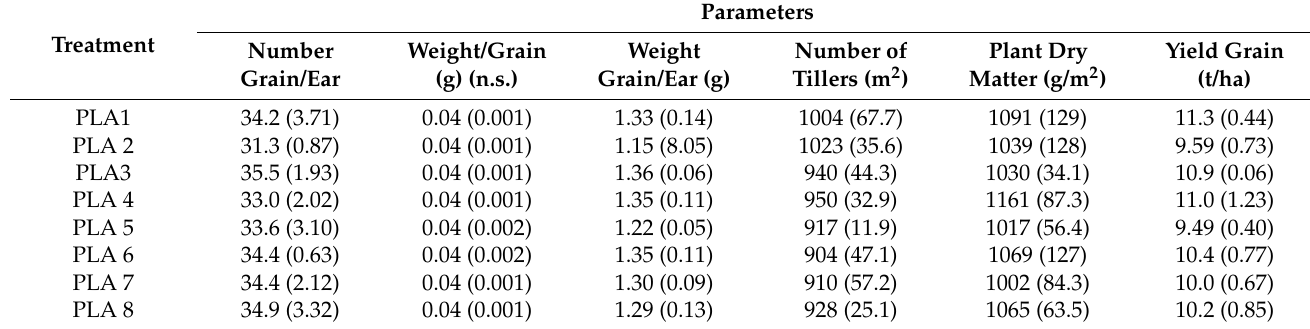
Table 3. Comparison of wheat growth parameters among treatments. Mean values and (Stdev). No significant differences were found among treatments according to one way